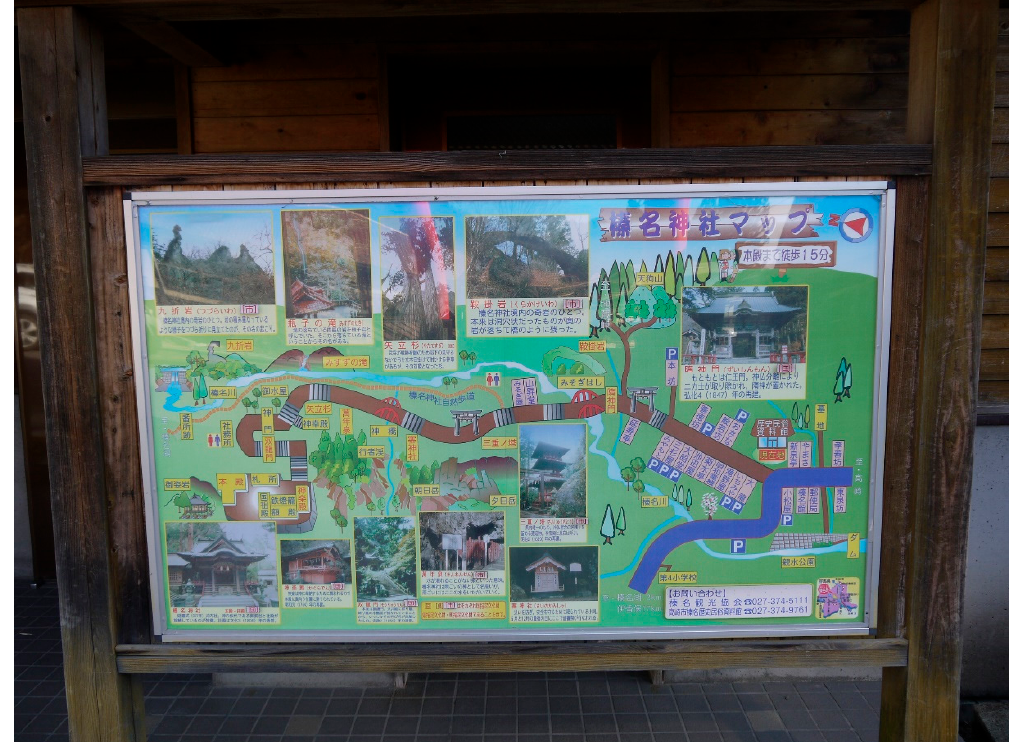
Figure 2. “Haruna Jinja Mappu (Haruna Shrine Map),” guide plate for visitors at Haruna Shrine Town by Haruna Tourism Association. Location and names of buildings in Haruna Shrine (left side) and accommodations and shops in Haruna Shrine Town (right side) are written in Japanese. Photo by author on 19 December